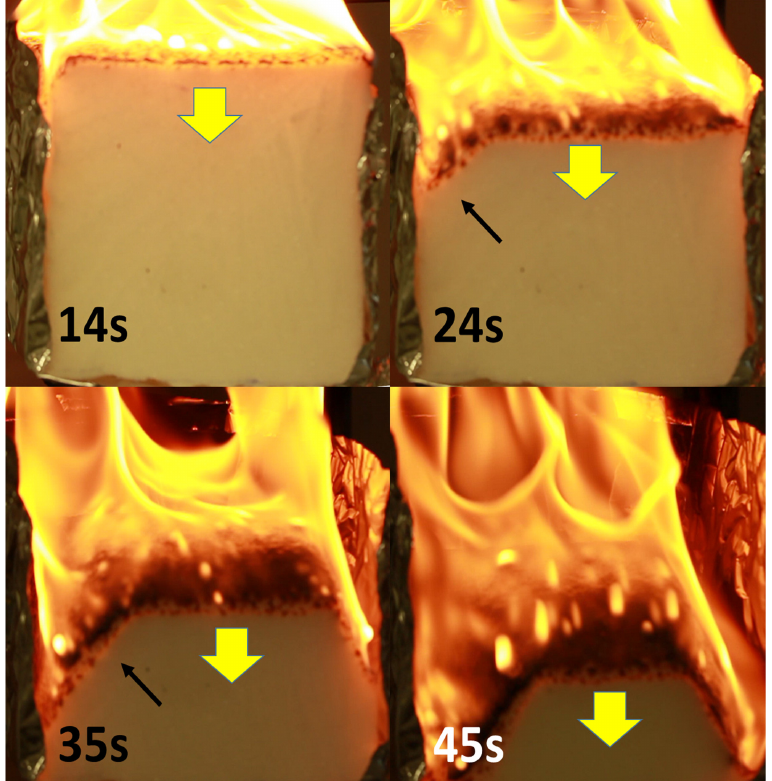
Figure 7. Some pictures from the digital camera for the HD foam collapse during the cone calorimeter test at 35 kW/m 2 (sample thickness 10 cm). Pictures from the IR camera are shown in Figure 8 for the HD foam at 35 kW/m 2 . Once again, these pictures are similar for other tests. There is a strong heat gradient and a clear border between the upper boiling material and the lower intact foam. The luminous upper part is due to the high temperature foam under burning (temperature of the upper surface reaches 600 °C while the temperature range measures by the infrared camera in this test is 0–275 °C), but also due to the aluminium foil gradually as the foam collapses. Once again the border moves through the foam thickness parallel to the surface. Black arrows show the foam sides moving at a higher rate. The white arrow highlights the flowing of the melted material at the end of the test (after collapsing).